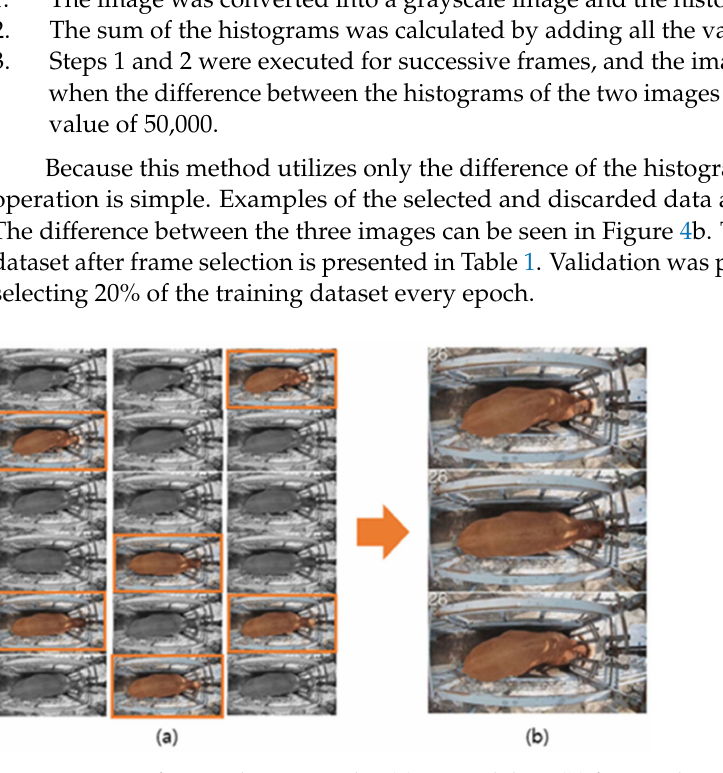
Figure 4. Image frame selection results: ( a ) original data; ( b ) frame selection results. Table 1. Configuration of the